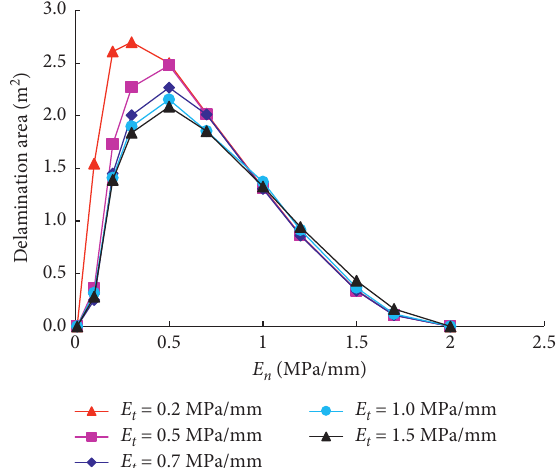
Figure 24: The delamination area versus E the impact energy of